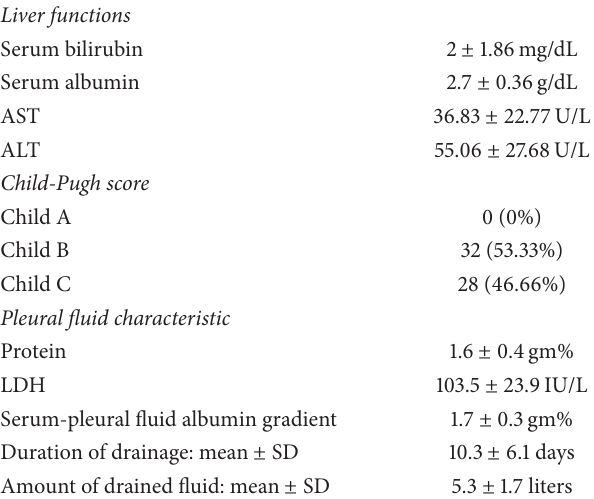
Table 1: Liver function tests, child score, and pleural fluid charac- teristic of the studied patients.